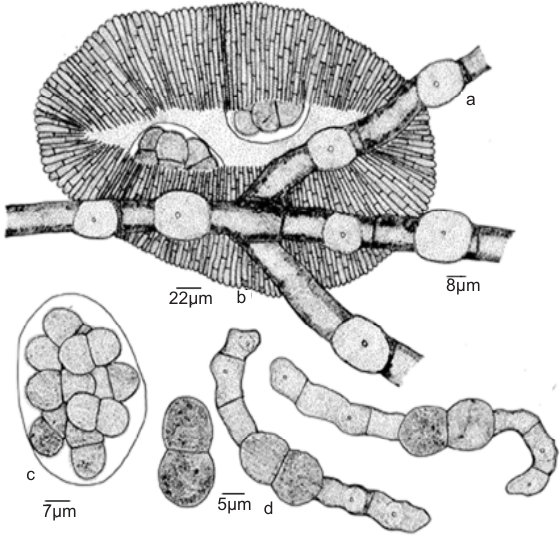
Figure 2 .The genus Cirsosia Arn. a - Intercalary appressoriate mycelium; b - Thyriothecium; c - Ascus; d.